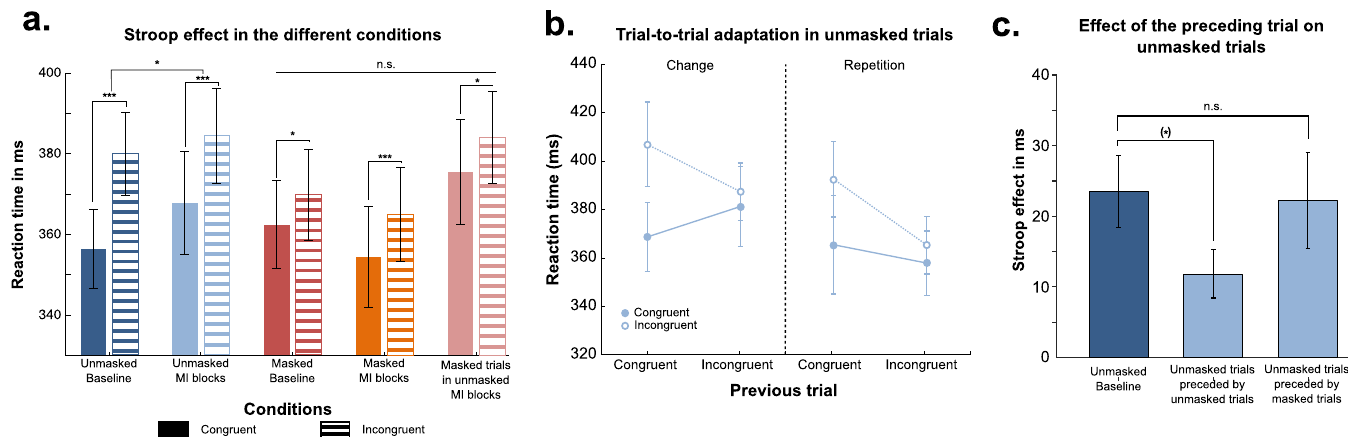
Fig 2. Behavioral results. (a) Stroop effect, as measuredby the difference in reactiontimes betweenincongruentand congruent trials, is presented in the different experimental conditions. The Stroop effect is strongly reducedin the unmasked mostly-incongruent (MI) blocks comparedto baseline,but no difference relative to baselineis observedfor masked trials. (b) Reactiontime is presented accordingto the current trial congruence and the previoustrial congruence, both for physicalrepetitionand changeacross the previous and current trials. A significanttrial-to-trial conflict adaptation effect was observed, that was not modulated by physicalrepetitionfactor. (c) Stroop effect for unmaskedtrials is presentedaccordingto the visibilityand the congruence of the previous trial. It is significantly different from baselineonly when the preceding trial is unmaskedand incongruent, suggestingan onlineevaluation of the instructed